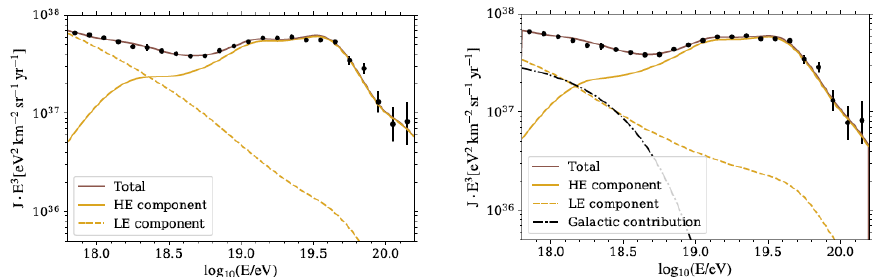
Figure 2. Left : The expected low-energy and high-energy contributions in the assumption of pure Figure 1. Left : Energy spectrum obtained with the best-fit parameters for [8]. Partial spectra are shown extragalactic contribution, here shown as dashed and solid lines, respectively. Right : The expected with di ff erent colors, total spectrum with brown. Full circles show the experimental spectrum. Right : low-energy and high-energy contributions, as well as the expected end of the Galactic spectrum, in the average and standard deviation of the X max for data (full circles) and best-fit prediction (brown). Pure H assumption that this influences the cosmic-ray flux in the energy region of (red), He (grey), N (green) and Fe (blue) are shown as dashed lines. Only the energy range where the brown lines are solid is included in the fit. From [8].